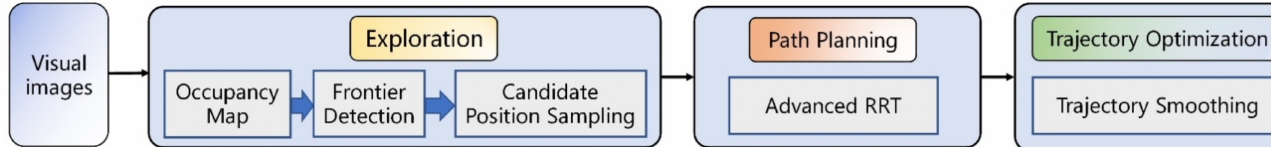
Figure 2. System overview of our proposed FSEPlanner autonomous exploration and trajectory planning framework.